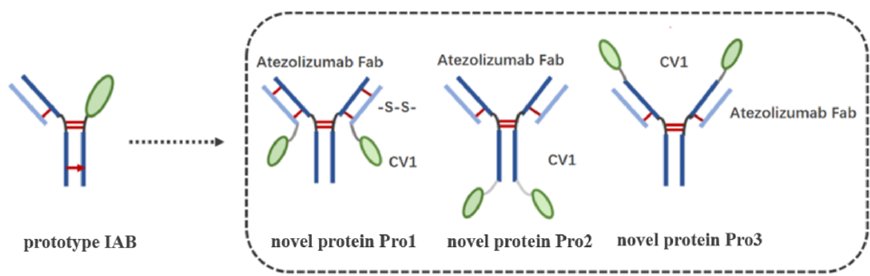
Figure 2. Design and schematic representation of the structures of the three dual-targeting proteins. The left “prototype IAB” is the structure of prototype IAB [12]. Prototype IAB was developed using “knobs into holes” technology, which is represented by a red arrow.